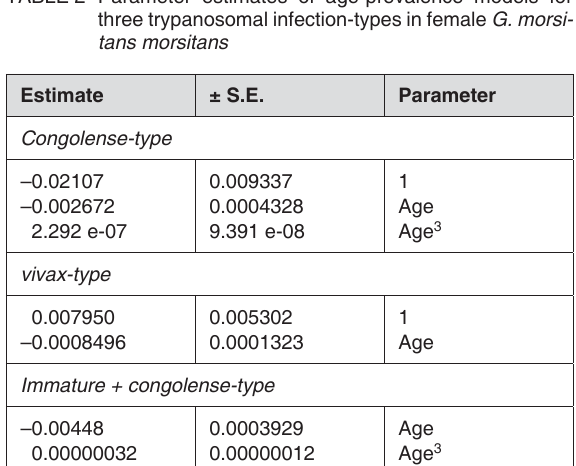
There was no significant yearly variation in the prev- alences of any of the infection types and no effect of year on the shape of the monthly variation of any of the infection types. For congolense -type infections, only age had a significant effect on prevalence. Monthly variation in prevalences were not signifi- cant. For vivax -type infections both age and month, but not their interaction, were significant factors. The monthly prevalence of vivax -type infections varied from 0.7 % in October to 3.6 % in December. For the sum of immature and congolense -type in- fections both age and month, but not their interac- tion, were significant factors explaining the variation in the prevalence. Average estimates of infection prevalences with age, for the whole of the study pe- riod, were obtained, ignoring the effects of month and year. Age-prevalence relationship The observed age-prevalence relationship for con- golense -type and vivax -type infections are shown in Fig. 1A and B. The prevalence of congolense -type infections ranged from 0 % (OCs 0A and 0B) to 9.5 % (OC 6B). For vivax -type infections the prevalence varied be- (1 – y) = λτ – λ a was fitted to the age prevalence data of the congolense -type and vivax -type infec- tions to obtain estimates of the per capita infection rate ( λ ) and developmental period ( τ ). The fitted curves are listed in Table 2 and plotted, together with the observed prevalences, in Fig. 1A and B. For the congolense -type infections, the model in- cluded a cubic term of age which significantly im- proved the fit (F = 5.95, P < 0.01). The model 1,16